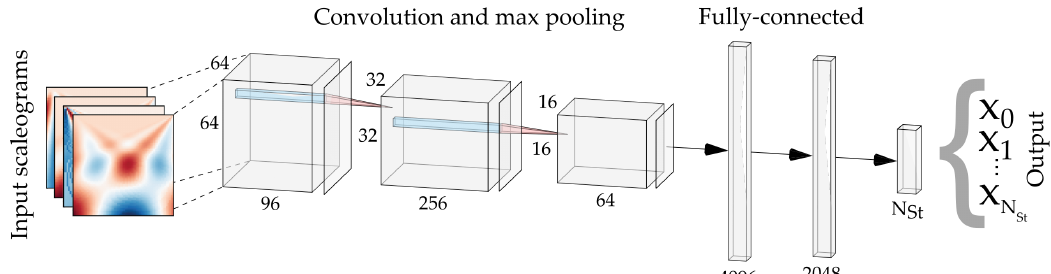
Figure 3: Schematic architecture of the 2D CNN that is used in this work. The multi-channel input image comprises five (nine) stacked CWT scaleograms of ther- modynamic observables. The image first passes through three convolution and max- pooling layers. This allows the network to extract features from the images. The two following fully connected layers then predict the N { x } in the output nodes. Here, N , x ,..., x N P 0 1 (hexagonal, tetragonal)